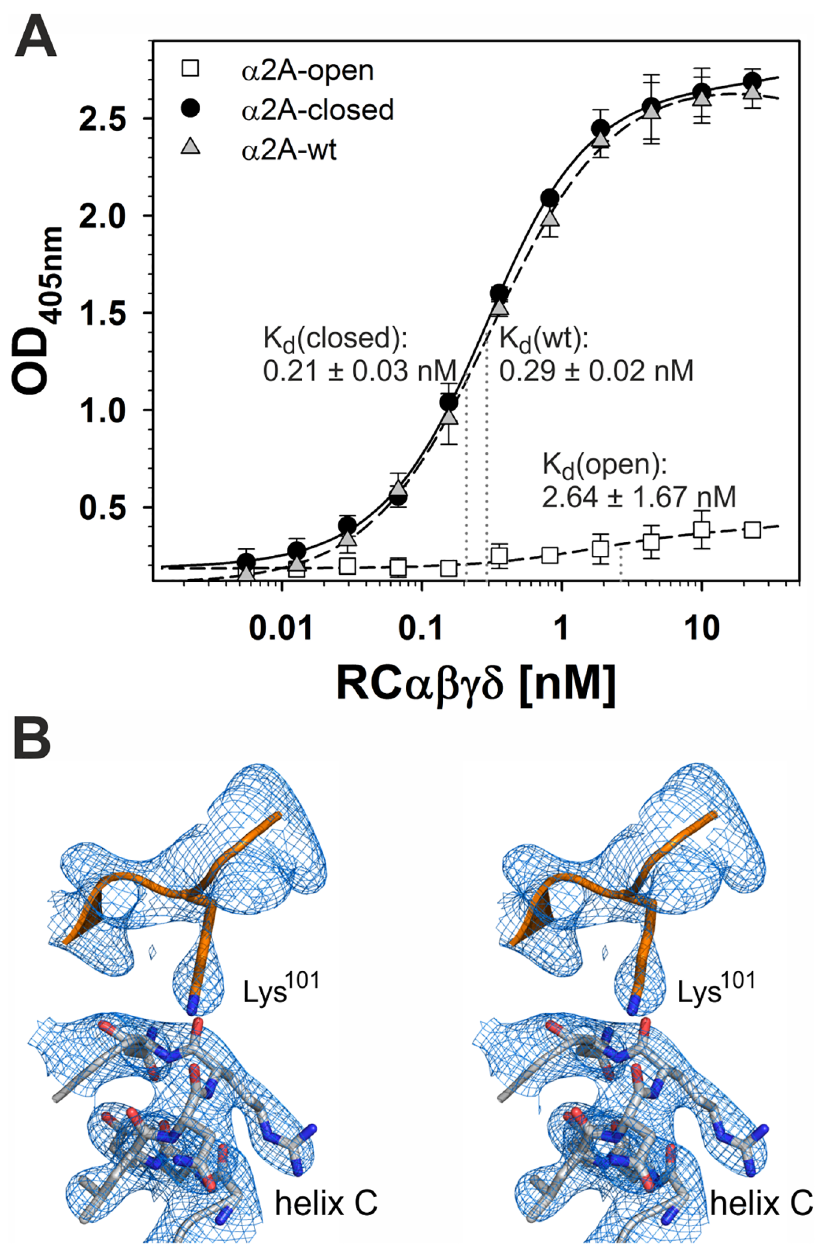
Fig 3. Rhodocetin (RC) recognizes the “closed” conformation but not the “open” conformation of the integrin α 2A domain. (A) Titration of different α 2A conformations with RC. The disulfide-lockedconformation mutants, α 2A open ( □ ) and α 2A closed ( ● ), were immobilizedto microtiter plates at 10 μ g/ml. Along with immobilized α 2A wild-type(wt) form ( 4 ), they were titrated with RC αβγδ .Bound RC was fixed and quantified with a rabbit RC antiserum by ELISA with a photometric signal at 405 nm. The OD 405 values were corrected for α 2A domain-free, bovine serum albumin(BSA)-blockedcontrols. The data presentedhere are taken from three independent experiments, with each measurement made in duplicate. Means ± SD ( n = 6) are shown. The K d values for RC bindingto the disulfide-locked conformation mutants and the wt form of α 2A are indicatedat the titration curves. Both “open” and “closed”conformations have significantly different K d values when comparedto the one of the wild type form ( * p < 0.05, Student t test). The data are summarized in S1 Data. (B) The crystal structure of the RC γδ - α 2Acomplex revealsthat the “closed” conformation of the α 2A domainwith its characteristic helix C is stabilizedby the bound RC δ subunit. A stereo view of the Sigma-A weighted2Fo-Fc map at 3.0 Å resolutionis shown at 1.5 σ contour level.